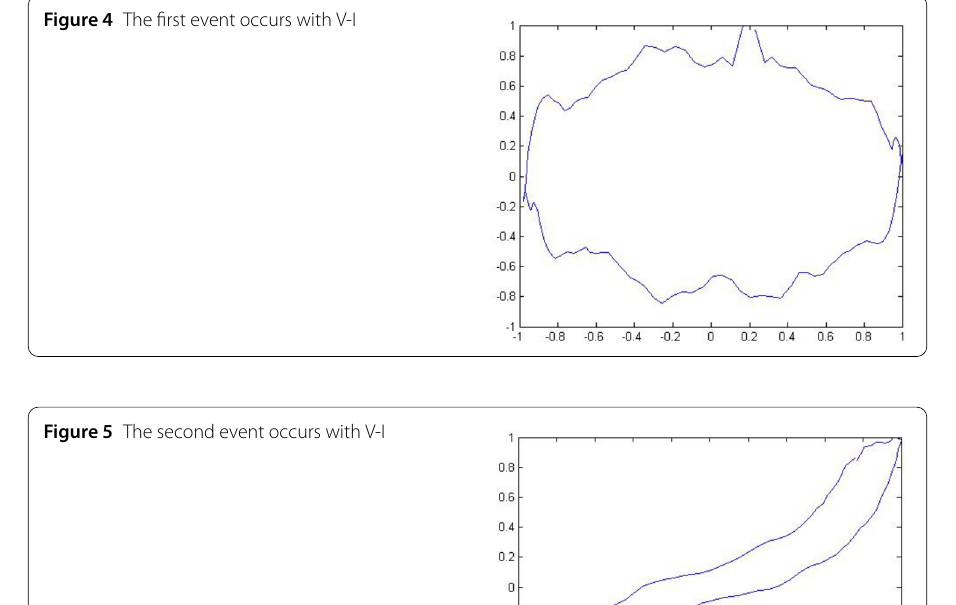
Figure 5 The second event occurs with V-I